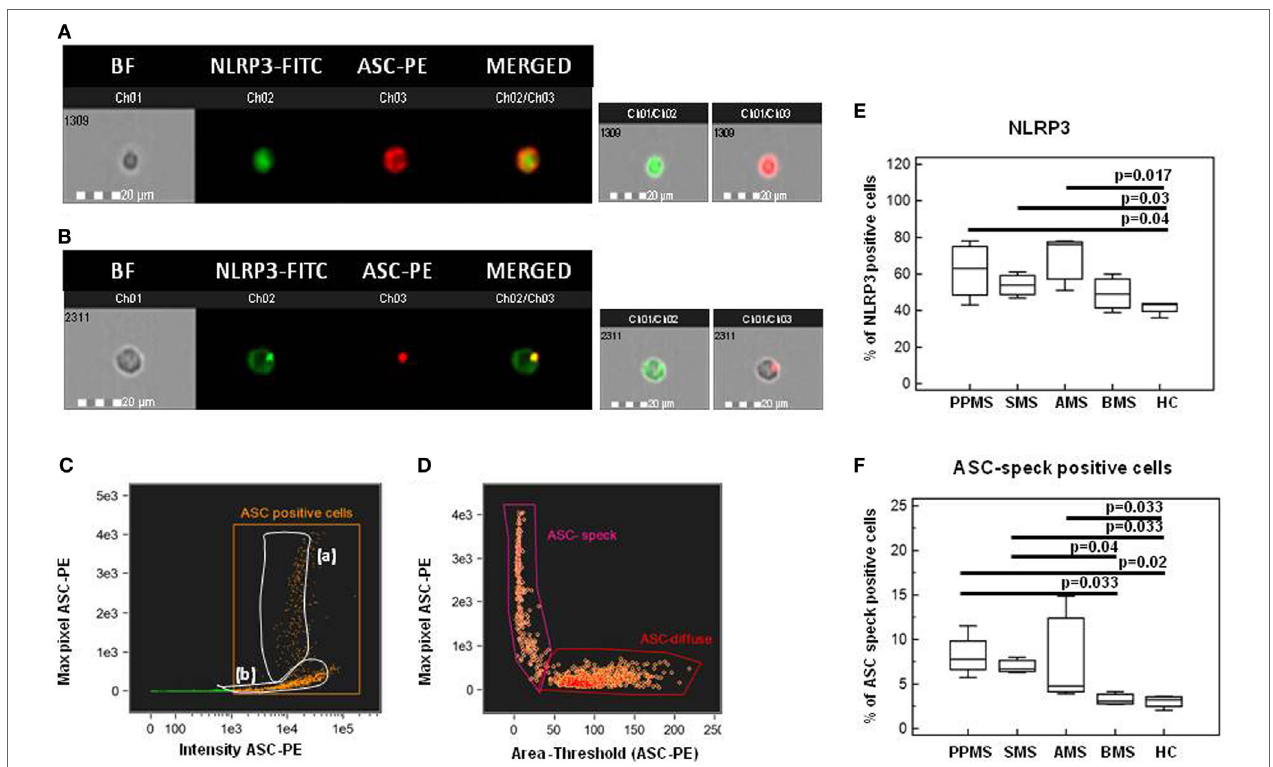
FigUre 7 | Nod-like receptor protein 3 (NLRP3) expression and apoptosis-associated speck-like protein containing CARD (ASC)-speck formation in lipopolysaccharide (LPS)-primed and monosodium urate crystals (MSU)-stimulated PBMCs. Representative images of NLRP3 expression and ASC-speck formation in LPS-primed and MSU-stimulated PBMCs. [ (a) , ASC-diffuse; (B) , ASC-speck]. The first column shows cells in brightfield (BF), second column shows NLRP3-FITC fluorescence, third column shows ASC-PE fluorescence, and fourth column shows florescence of ASC merged with NLRP3 (IDEA software). The percentage of ASC speck positive cells was performed using the same mask of internalization feature (c) , differentiating spot (speck) or diffuse fluorescence inside of cells (DF): threshold mask was used to separate all ASC positive cells population in ASC-speck spot cells or ASC-diffuse cells by the different diameter of the spot area (D) . In ASC-speck cell, the spot shows a small area and high max pixel, conversely, in ASC-diffuse cell, the fluorescence shows a large area and low max pixel. Summary results of NLRP3 (e) and ASC-speck positive cells (F) in LPS-primed and MSU-stimulated PBMCs of PPMS, SMS, AMS, BMS, and HC are shown in the bar graphs. The boxes stretch from the 25 to the 75 percentile; the line across the boxes indicates the median values; the lines stretching from the boxes indicate extreme